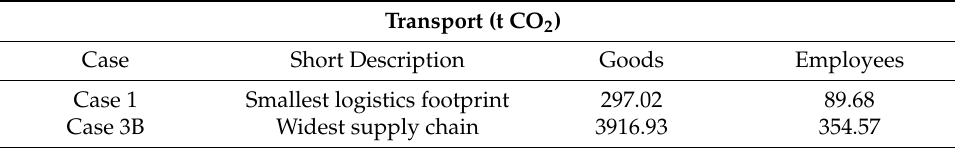
Table 39. Logistics CF of Case/Scenario 1 vs. Case/Scenario